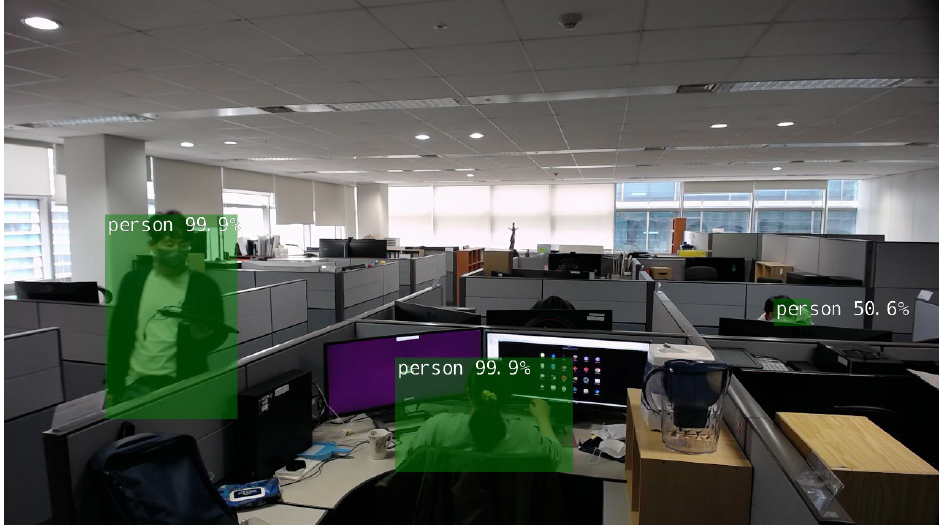
Figure 4. Indoor human object detection model’s implemented data collection unit. Table 2. Human object detection